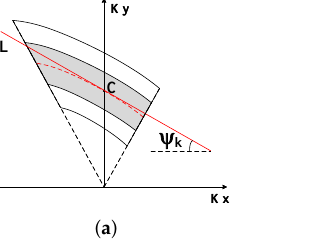
Figure 2. Illustrations of ( a ) wavenumber spectrum distortion and ( b ) distorted PSF in an EHS geometry with constant